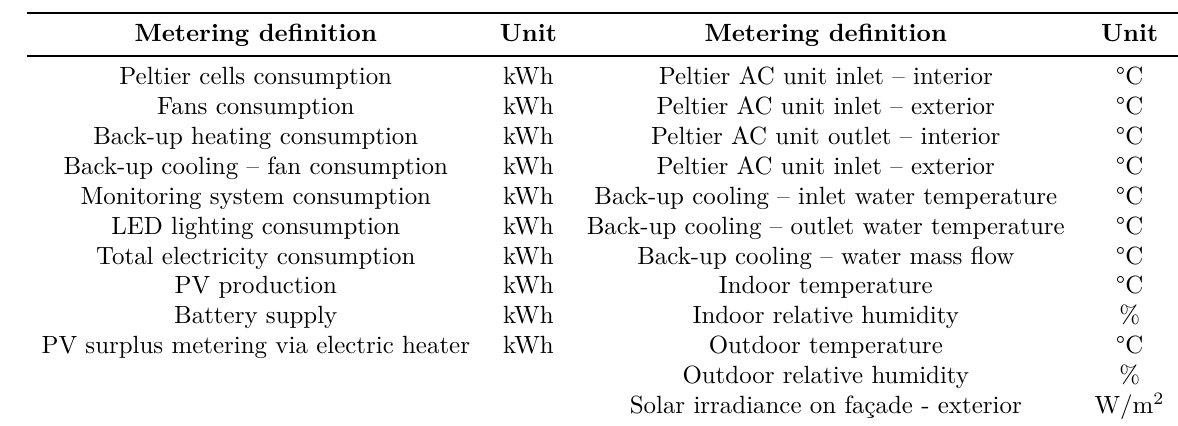
Table 1. List of measured variables.